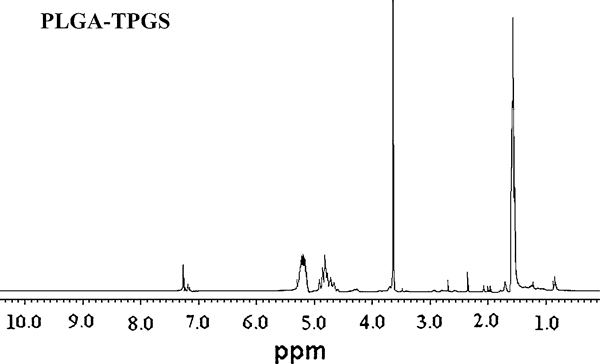
Typical 1H-NMR spectra of PLGA-TPGS random copolymer.